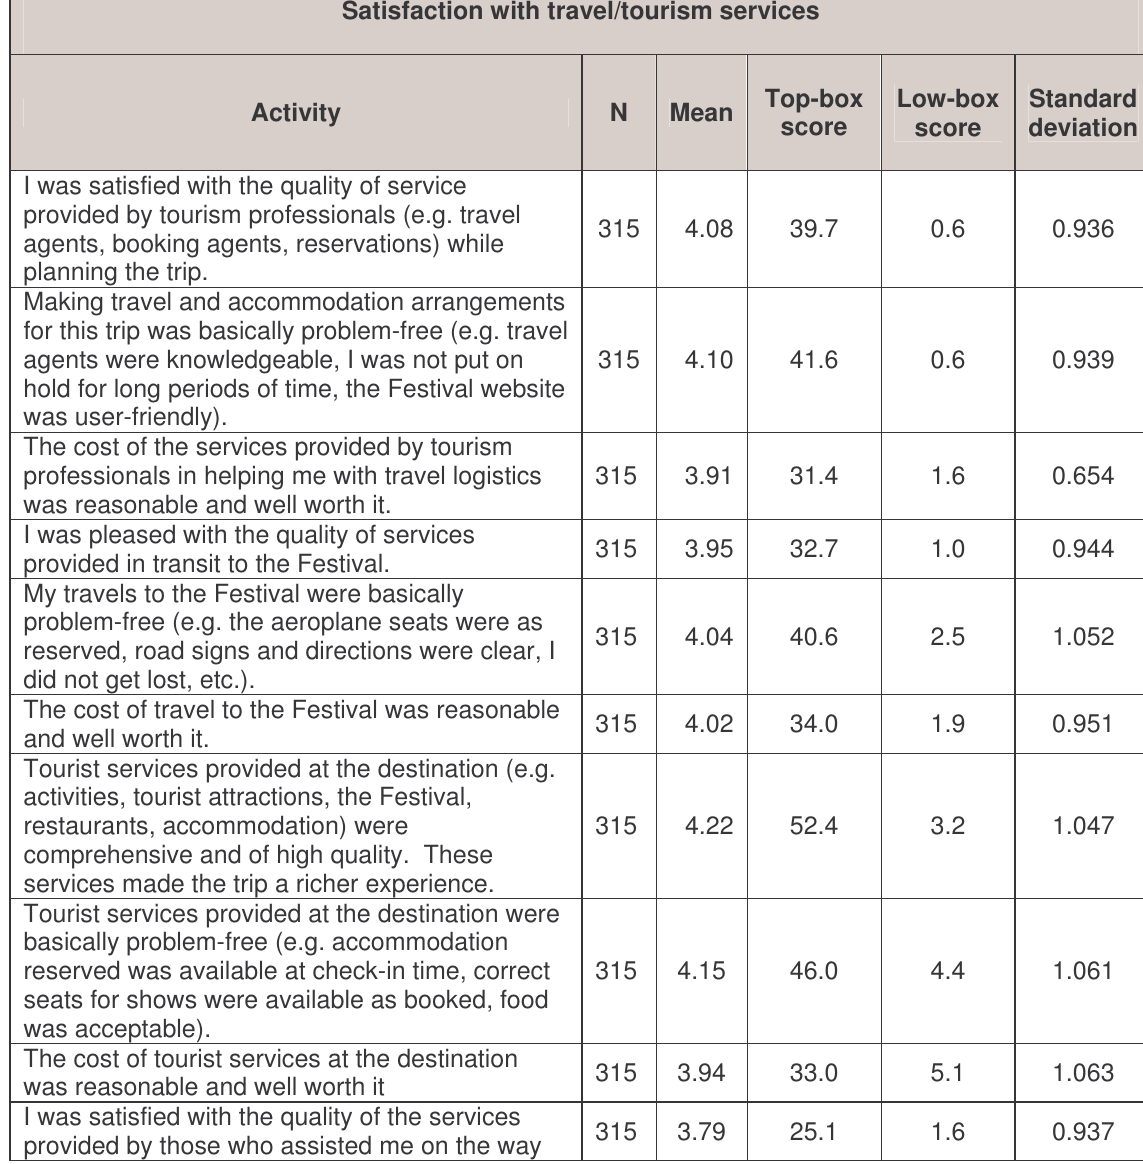
Table 3: Satisfaction with travel/tourism services Satisfaction with travel/tourism